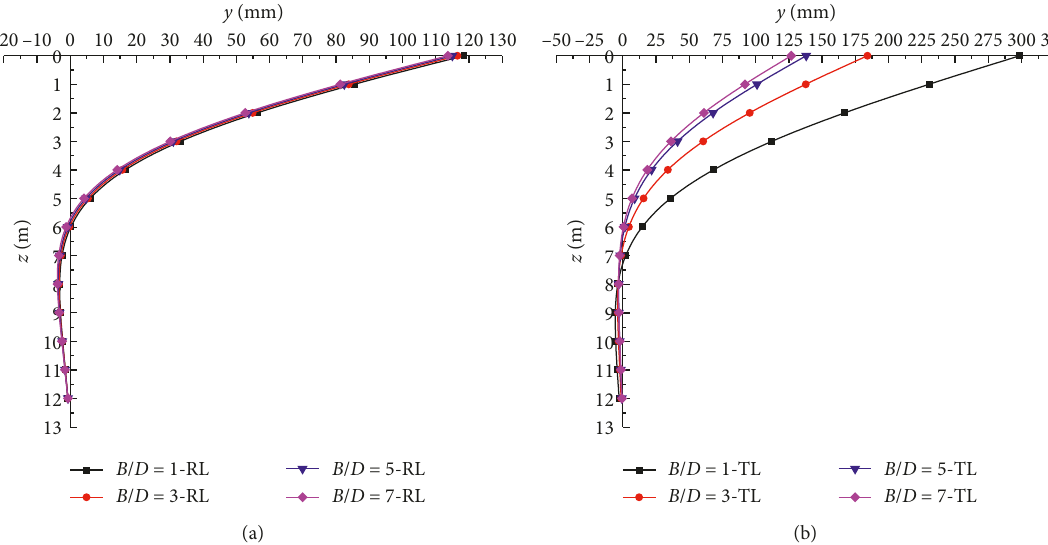
Figure 18: Pile deflection versus depth relationships under different loading directions for the 1V:1H slope at H loading. (b) Toward